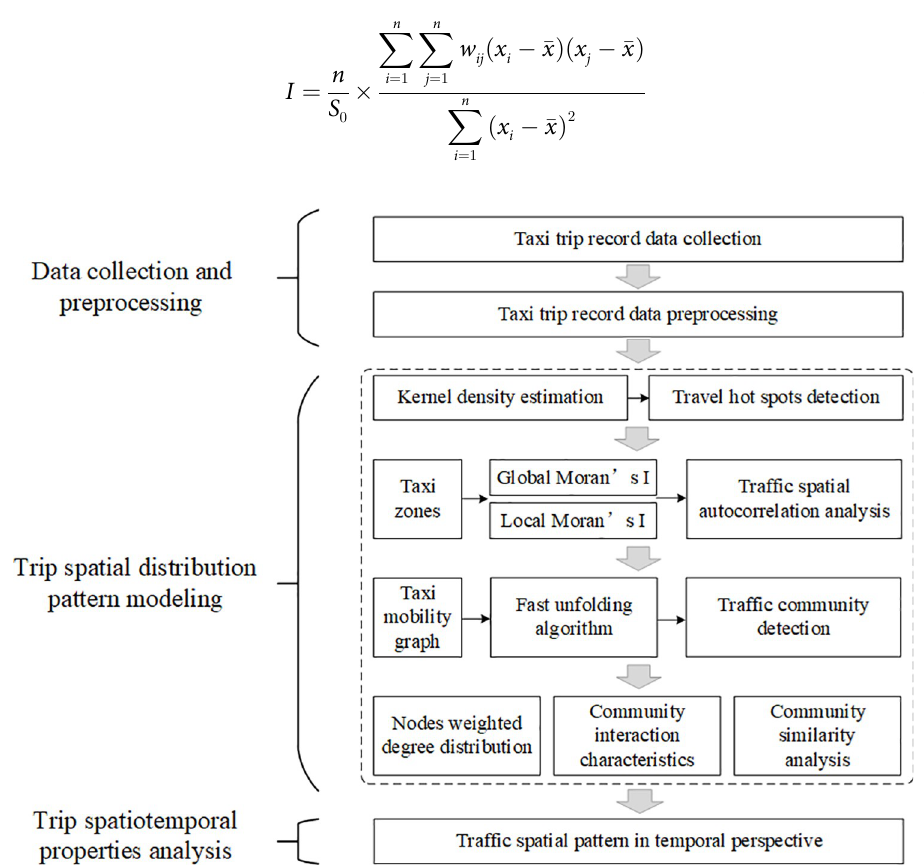
Fig 3. The logic framework of travel spatiotemporal